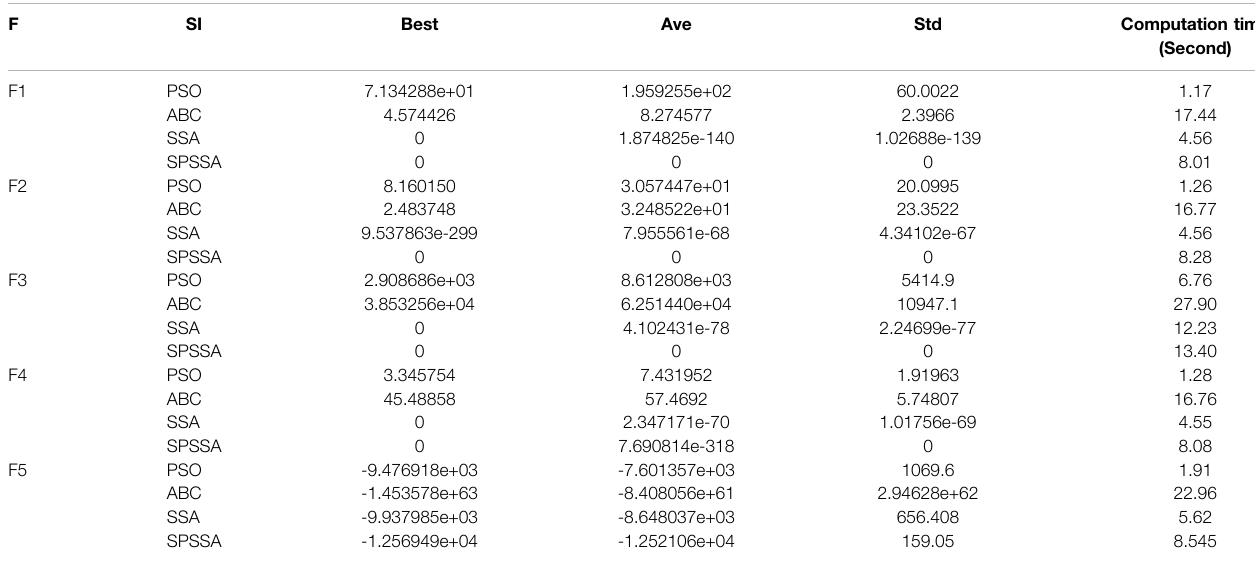
TABLE 2 | Experiment results of benchmark